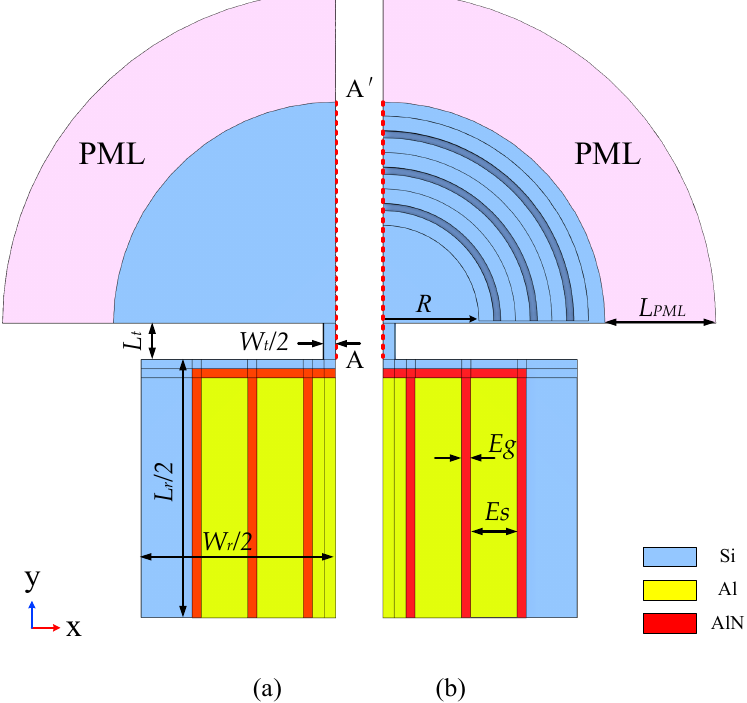
Figure 6. LWR model. ( a ) conventional simplified 1/4 model; ( b ) LWR 1/4 simplified model after adding three cycles of H-RPC.